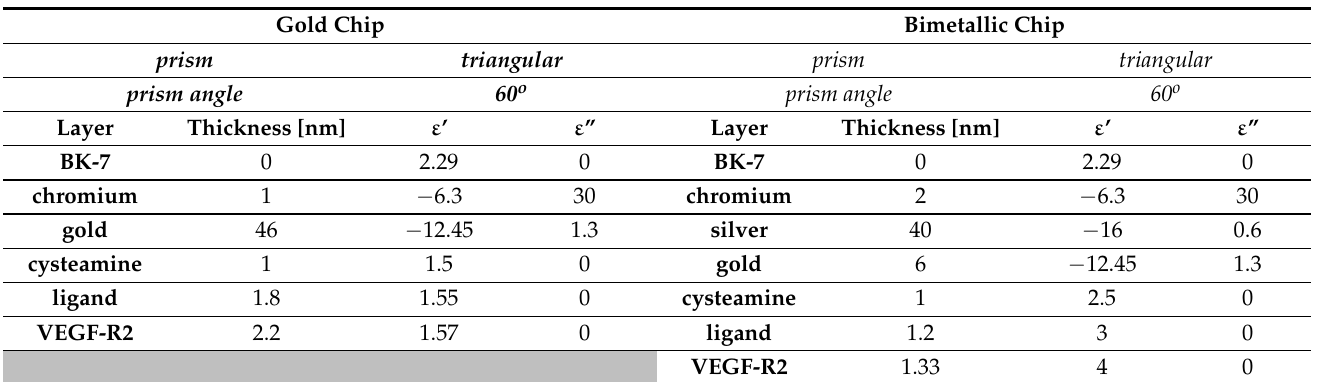
Table 2. Parameters used to model the SPR curves. ε ’—real part of the permittivity, ε ”—imaginary part of the permittivity.